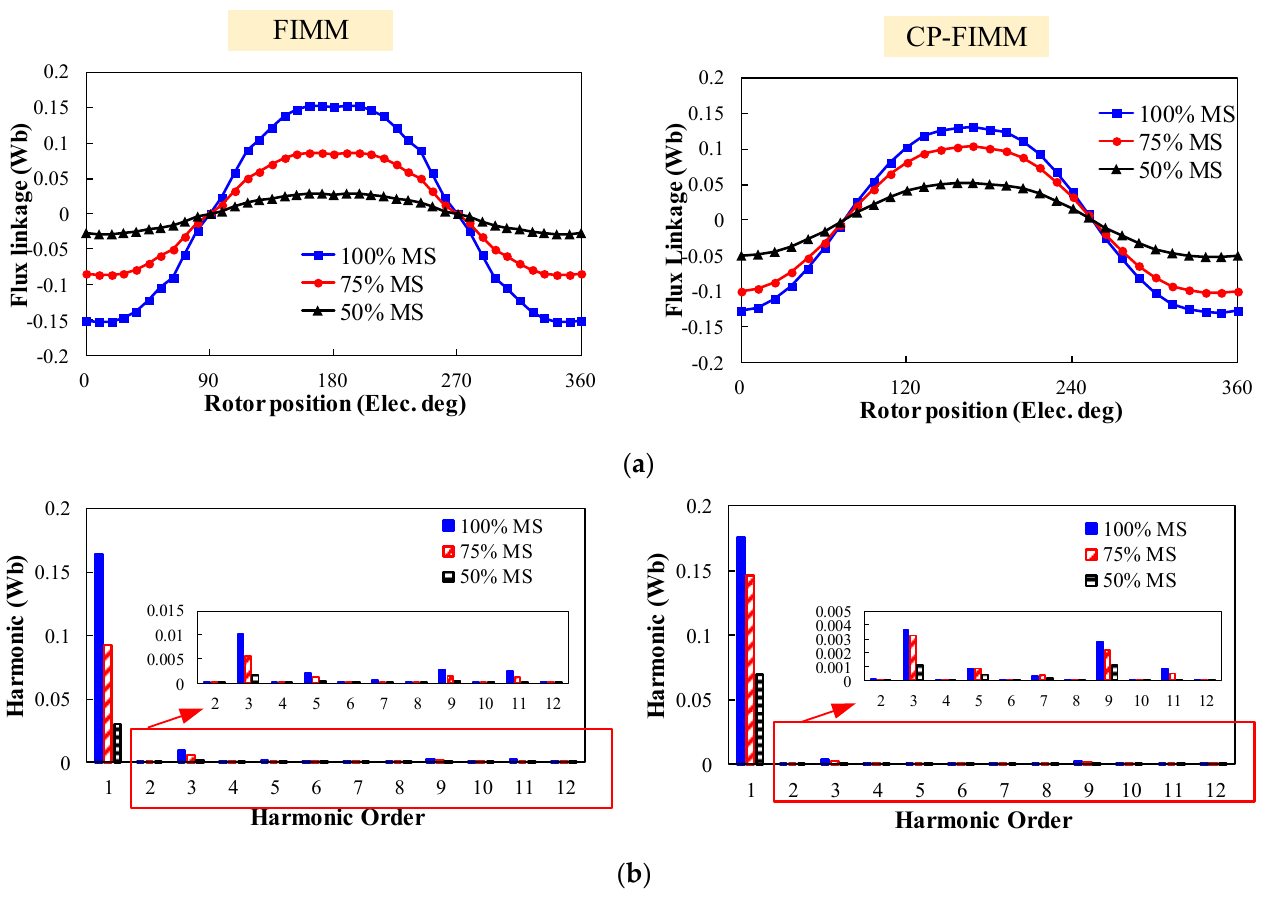
Figure 7. Flux linkage of the two machines. ( a ) Waveforms; ( b ) harmonic spectra.